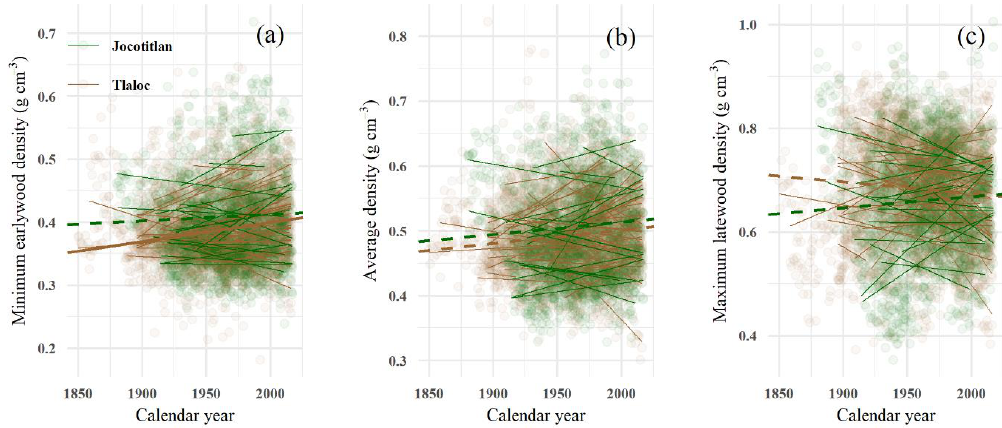
Figure 5. Linear mixed-e ff ect predictions for ( a ) minimum earlywood density—MID, ( b ) average density—AVE, and ( c ) maximum latewood density—MXD grouped by tree response. Thin lines represent individual trees and the solid line represents the average response. Note that continuous a line means that the calendar year e ff ect was significant while the opposite with the